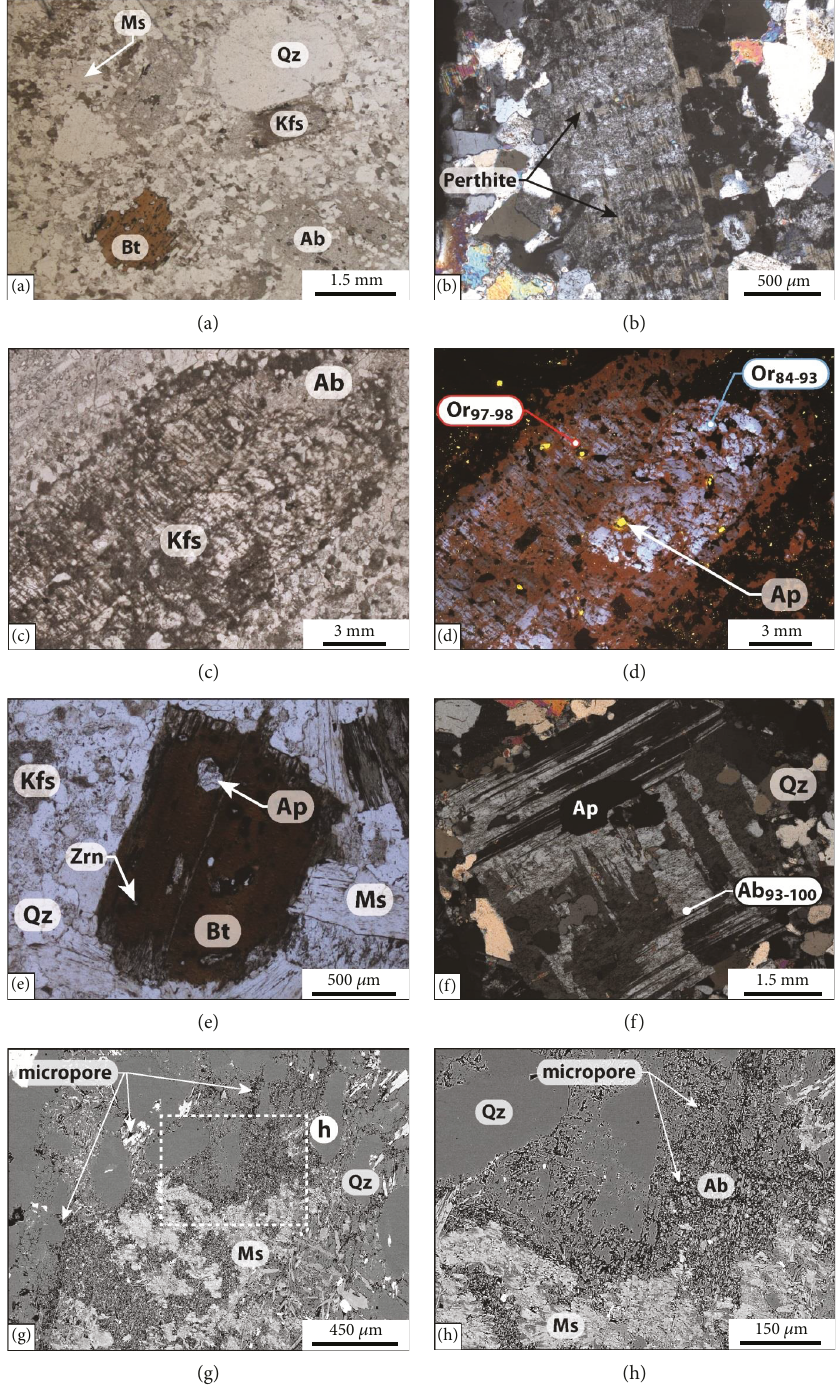
Figure 4: Mineralogical and microtextural characteristics of the two-mica Panasqueira granite. (a) Photomicrograph displaying a general view of the two-mica granite (transmitted light). (b) Photomicrograph of matrix K-feldspars exhibiting typical perthitic textures (polarized transmitted light). (c) Phenocryst of K-feldspar marked by poikilitic textures (inclusions of biotite, albite, and apatite) (transmitted light). (d) Cathodoluminescence image of the same k-feldspar phenocryst displayed in (c). This grain exhibits blue and red luminescent zones corresponding to di ff erent chemical compositions (indicated on image) that are related to K-metasomatism of primary magmatic alkali feldspars (blue luminescent zones). (e) Large euhedral fl ake of biotite containing numerous zircon and apatite inclusions (transmitted light). (f) Phenocryst of albite with quartz and apatite inclusions. The chemical composition of albite is indicated on the photomicrograph (polarized transmitted light). (g and h) SEM-BSE images of albite displaying typical pitted textures marked by the occurrence of a dense network of micropores. Abbreviations from Whitney and Evans [45]. Ab: Albite; Ap: apatite; Bt: biotite; Kfs: K-feldspar; Ms: muscovite; Or: orthoclase; Qz: quartz; Zrn: